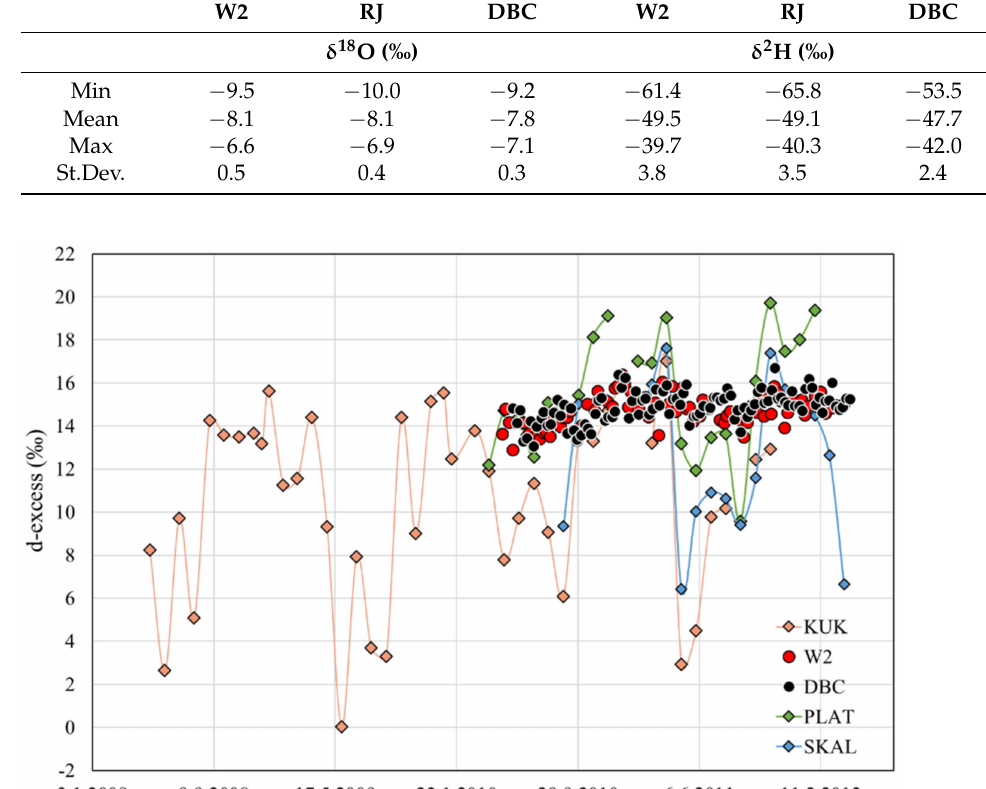
Figure 6. D-excess values for precipitation collected at the stations Kukuljanovo (KUK), Škalnica (SKAL) and Platak (PLAT) and groundwater from Martinš´cica well 2 (W2) and Dobrica (DBC) spring.